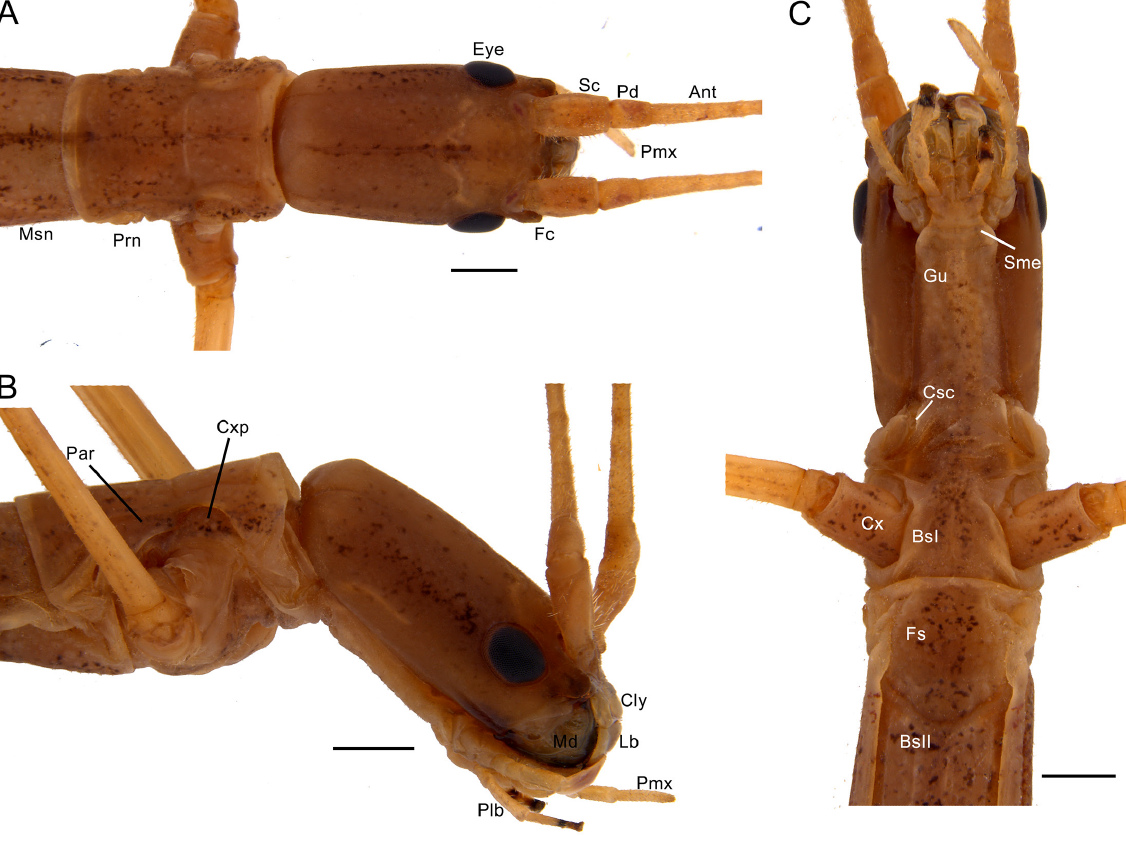
Fig. 26. Arumatia aramatia Ghirotto gen. et sp. nov., holotype, ♀ (MZUSP 1352), head and prothorax morphology. A . Dorsal view. B . Lateral view. C . Ventral view. Abbreviations: Ant = antennomere; BsI- II = pro- and mesothoracic basisterna; Cly = clypeus; Csc = cervical sclerite; Cx = coxa; Cxp = coxopleurite; Eye = compound eye; Fc = frontal convexity; Fs = prothoracic furcasternite; Gu = gula; Lb = labrum; Md = mandible; Msn = mesonotum; Par = paranota; Pd = pedicellus; Plb = labial palpus; Pmx = maxillary palpus; Prn = pronotum; Sc = scapus; Sme = submentum. Scale bars: 1